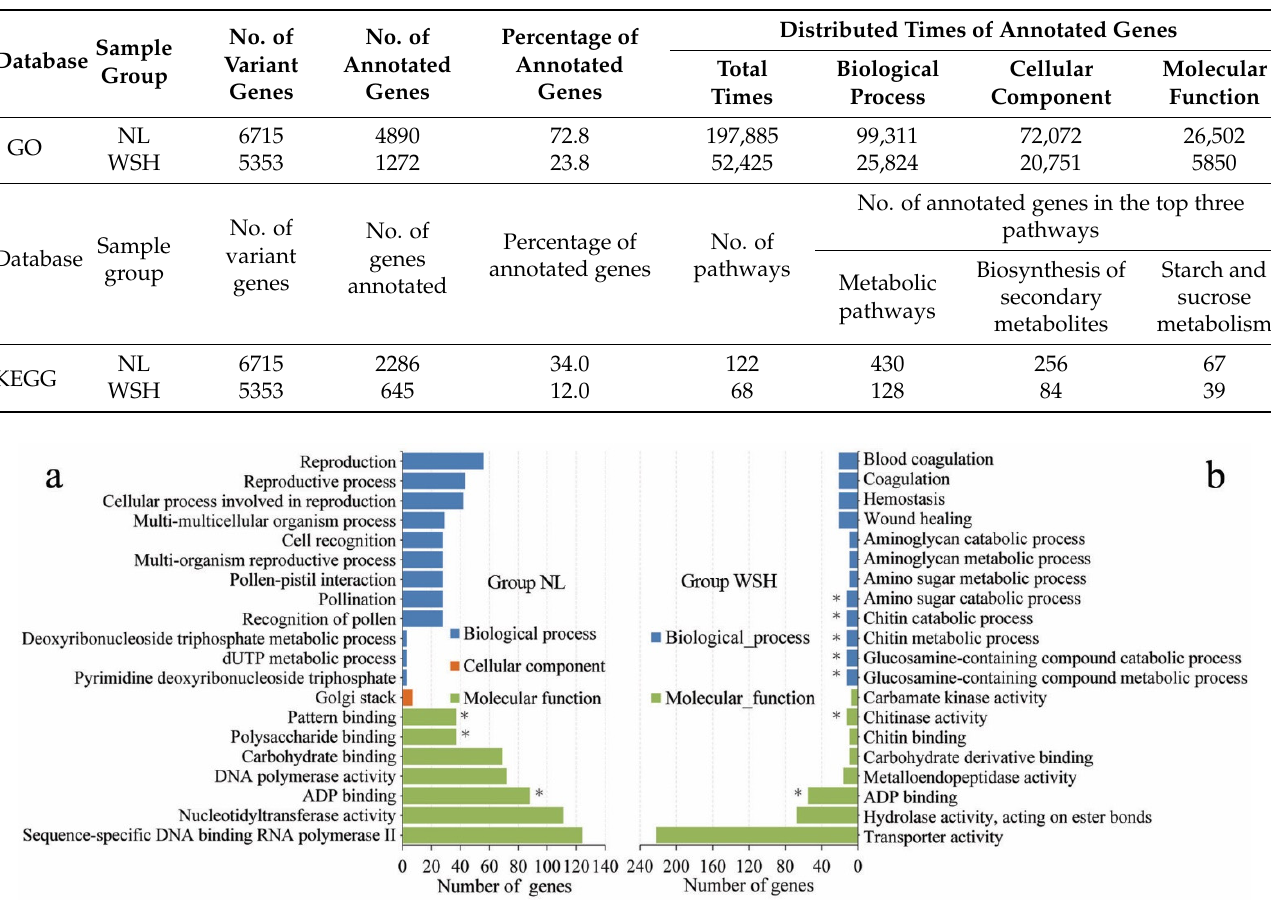
Figure 3. Top 20 of most enriched Gene Ontology (GO) terms among variant genes in NL group ( a ) and WSH group ( b ). GO terms showing significant differences ( Q < 0.05) within each group were indicated with an asterisk (*).